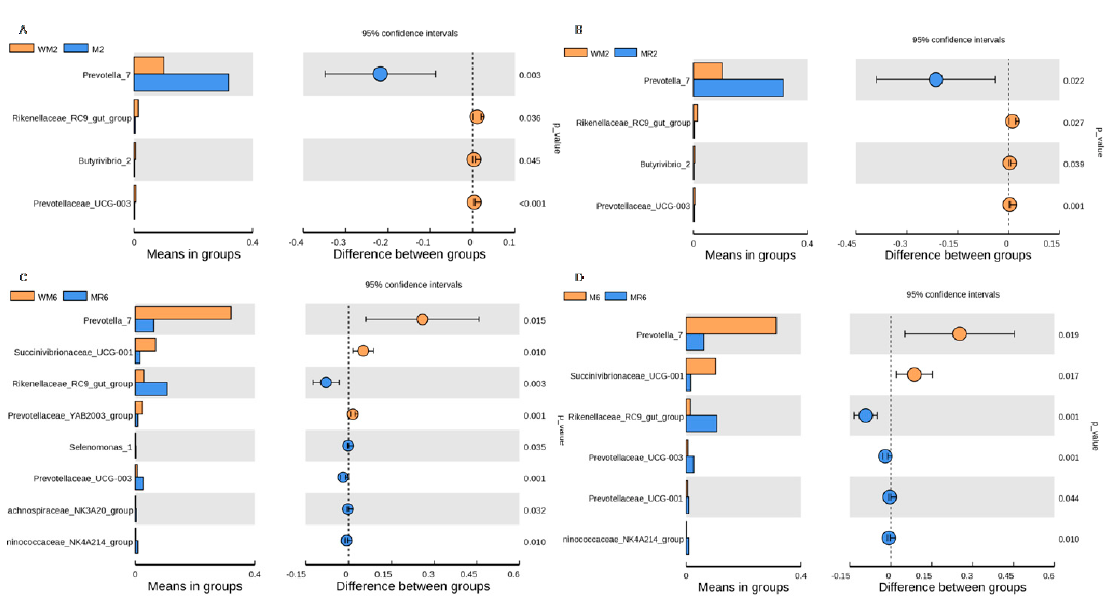
Figure 6. Taxonomic comparisons of the bacterial community at the genus level. Only different bacterial taxa ( p < 0.05, t test) with a relative abundance >0.1% in at least one sample were presented. ( A ) The WM2 and M2 groups; ( B ) the WM2 and MR2 groups; ( C ) the WM6 and MR6 groups; ( D ) the M6 and MR6 groups. WM2, M2, and MR2: rumen liquid was sampled at the age of two months from calves fed waste milk, milk, or milk replacer, respectively. WM6, M6, and MR6: rumen liquid was sampled at the age of six months from calves fed waste milk, milk, or milk replacer, respectively.